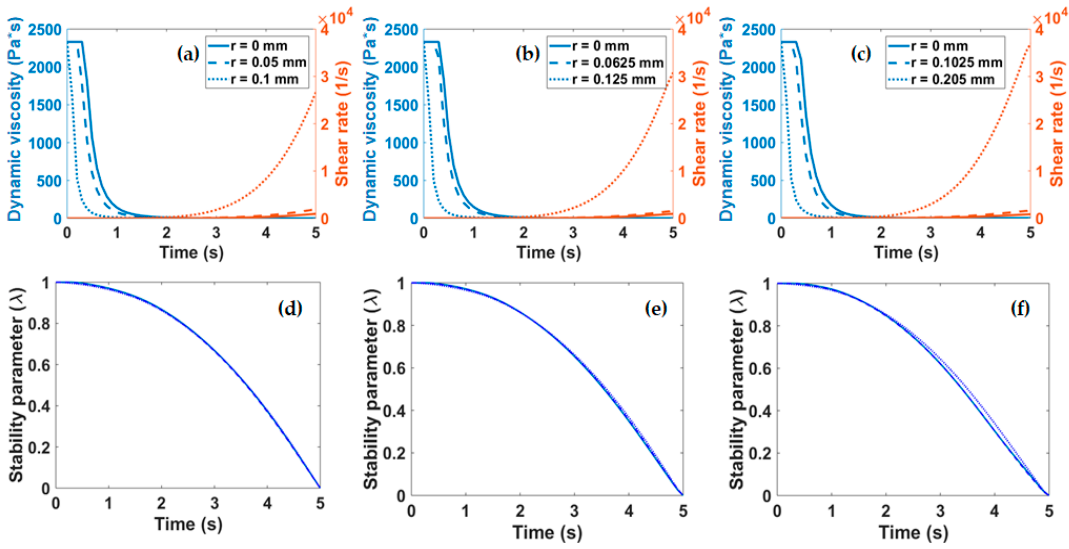
Figure 5. ( a – c ) Viscosity and shear rate as a function of time, measured at different points of the nozzle tip geometry (center, middle, and wall). Structural parameter for the three extrusion nozzles studied with diameters of ( d ) 0.21 mm, ( e ) 0.25 mm, and ( f ) 0.41 mm.